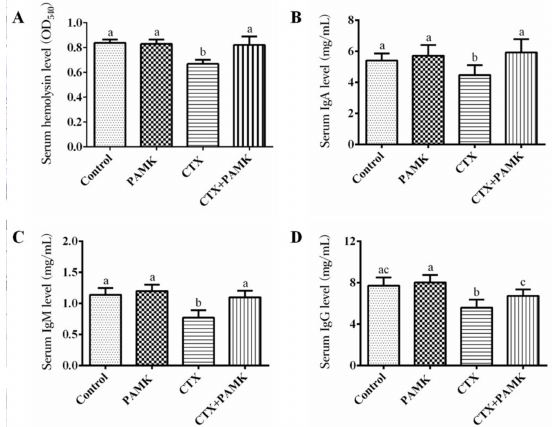
Figure 4. Effects of PAMK on hemolysin and immunoglobulin in the serum of geese treated with CTX. ( A ) Serum hemolysin levels (optical density at 540 nm; OD 540 ). ( B ) Serum IgA levels. ( C ) Serum IgM levels. ( D ) Serum IgG levels. The data are expressed as the mean ± SD, n = 8. Means with different letters represent statistically significant differences ( p < 0.05); the bars with the same letter are not significantly different ( p > 0.05).